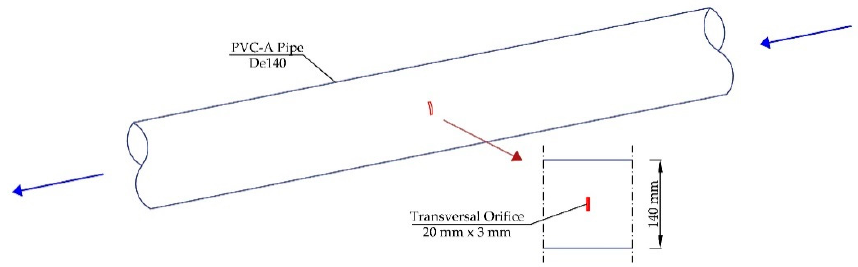
Figure 1. Graphic scheme of investigated PVC-A pipe with transversal orifice.